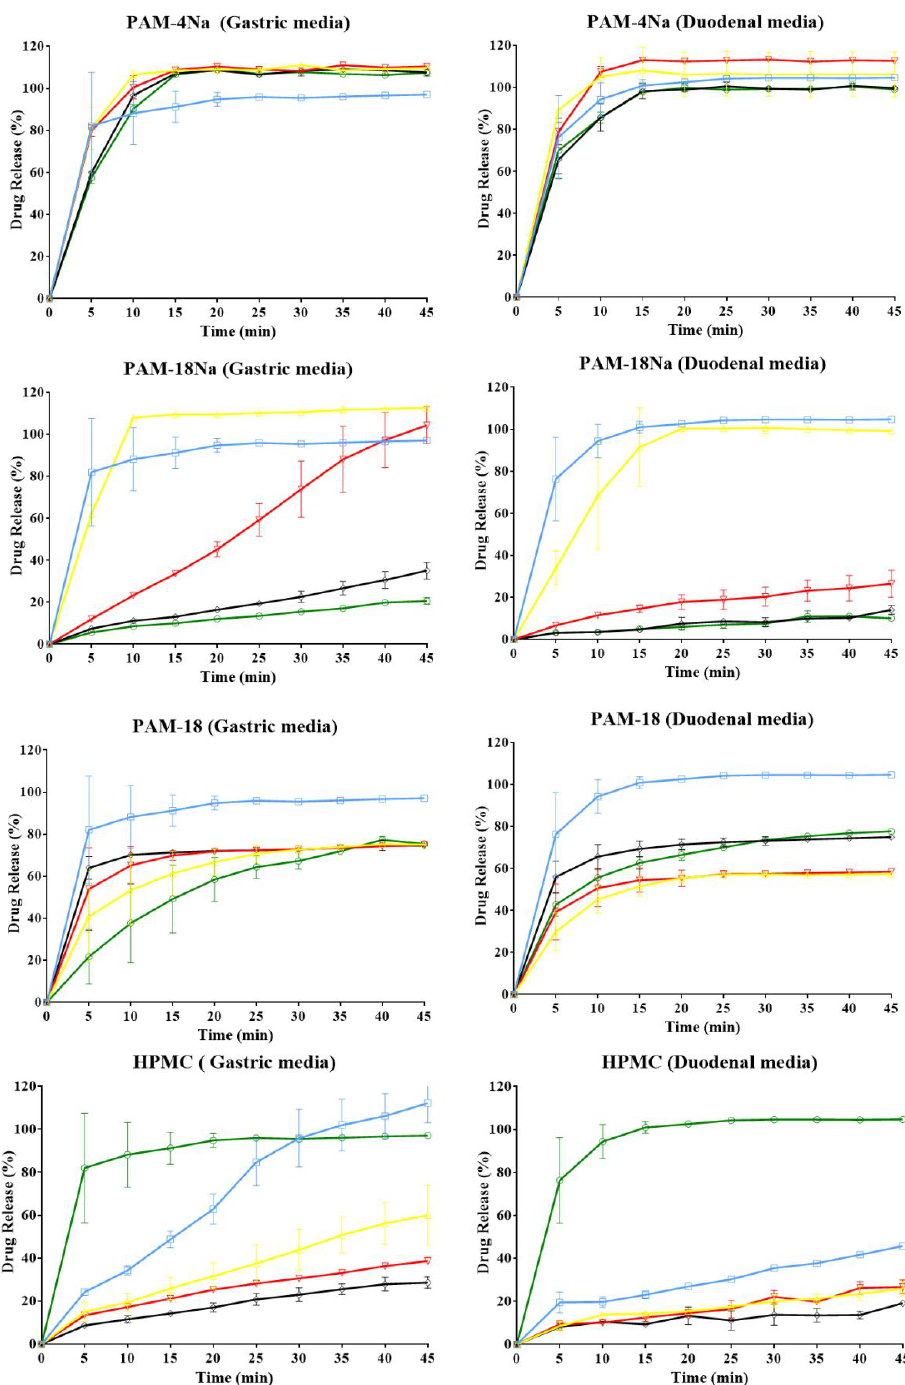
Figure 6. In vitro dissolution profiles of ampicillin trihydrate tablets using different polymer ratios: = 0%, = 10%, = 20%, = 30% and = 40% and two media for physiological simulation.